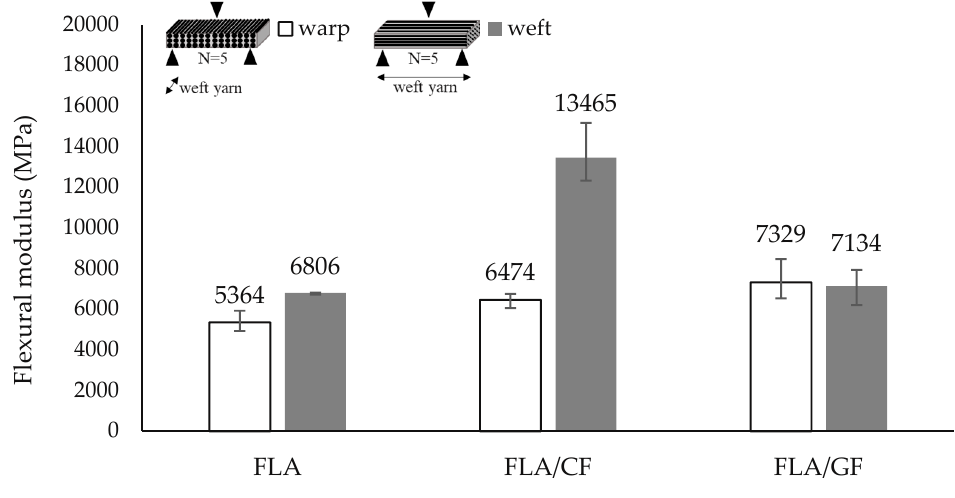
Figure 9. Flexural modulus of hybrid composites.